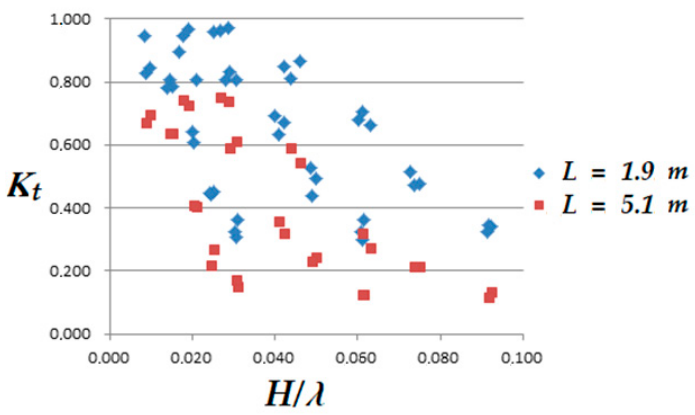
Figure 12. Relationship between wave steepness and transmission coefficient at different plate lengths.